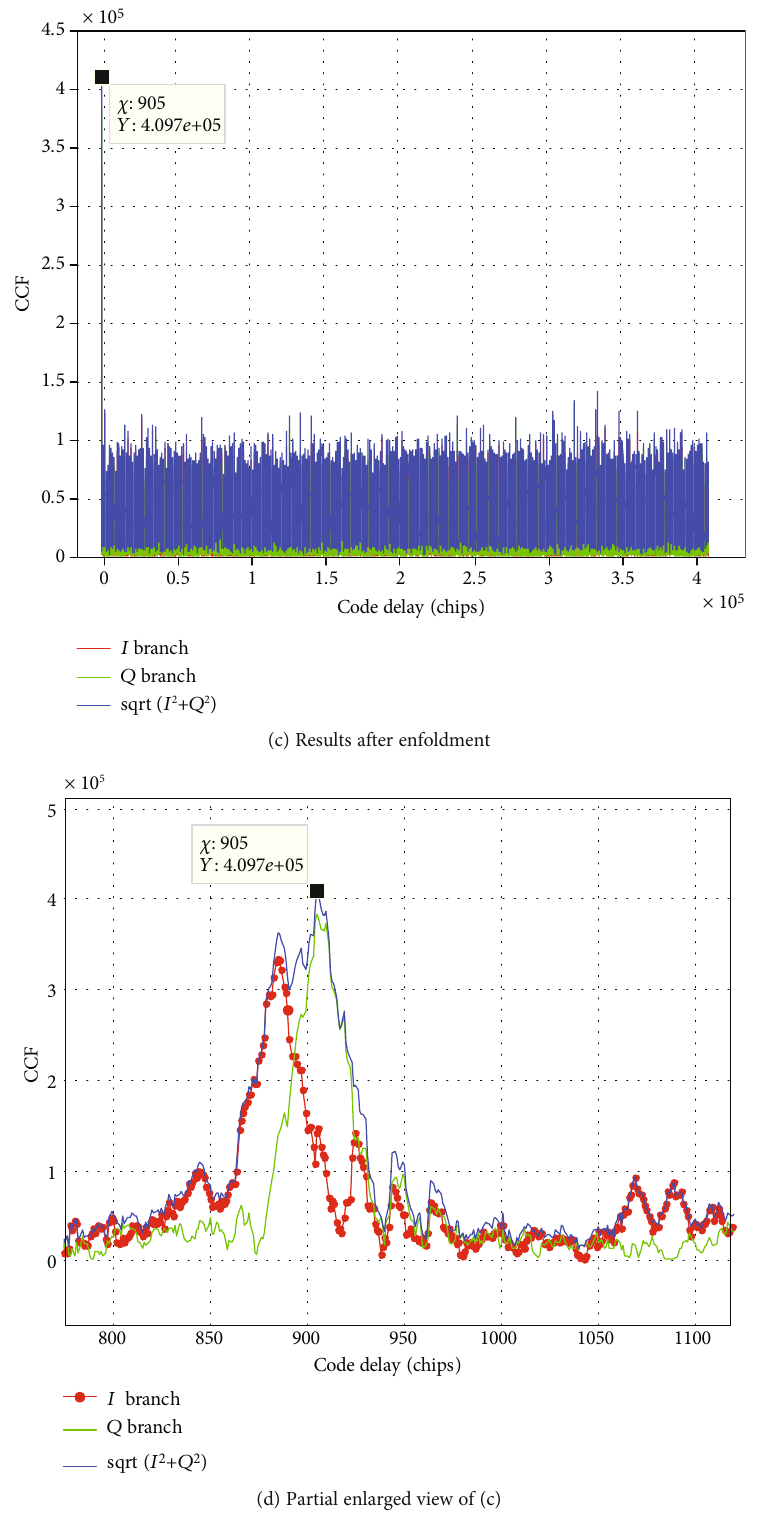
Figure 5: Correlation results of the correct